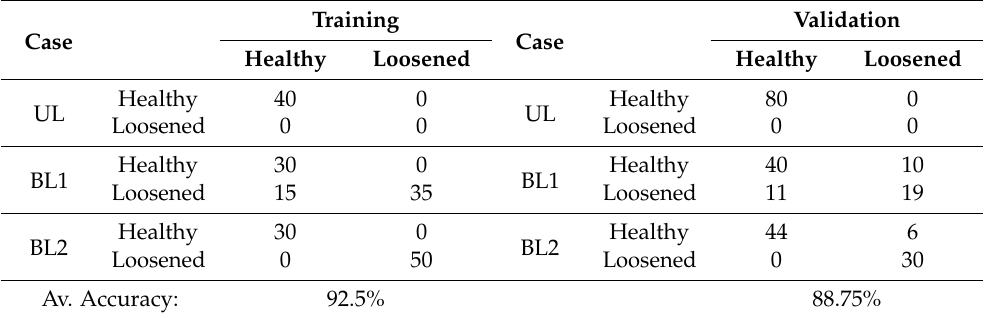
Table 4. Confusion charts show the average training and validation accuracy for experimental models.